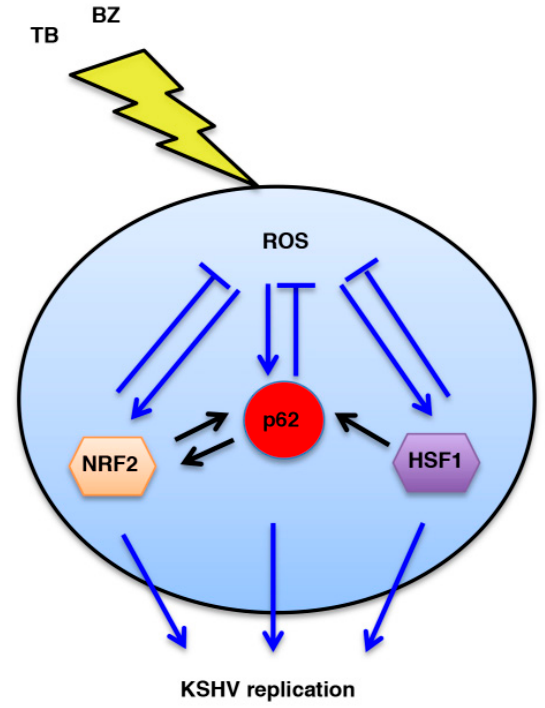
Figure 9. Schematic model. Interplay between HSF1, NRF2 and p62/SQSTM1 proteins and ROS intracellular production during KSHV replication induced by TB or BZ tratements.